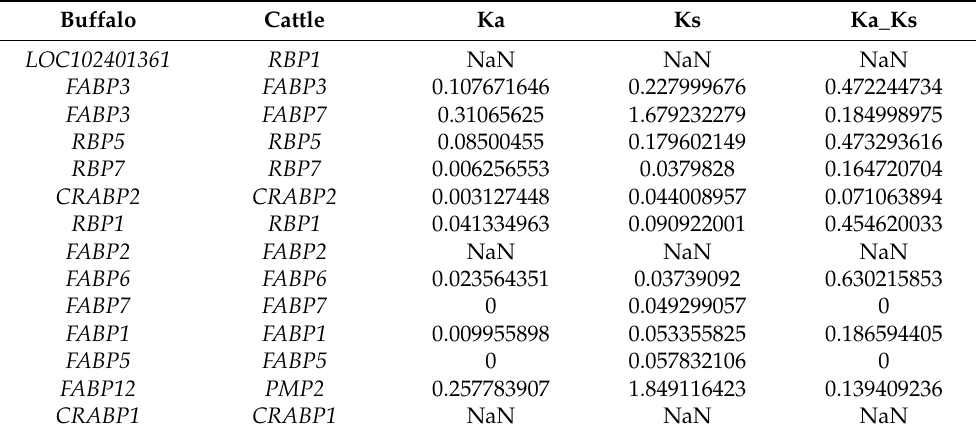
Table 3. Ka/Ks ratios estimated in the present work for buffalo and cattle orthologous FABP gene